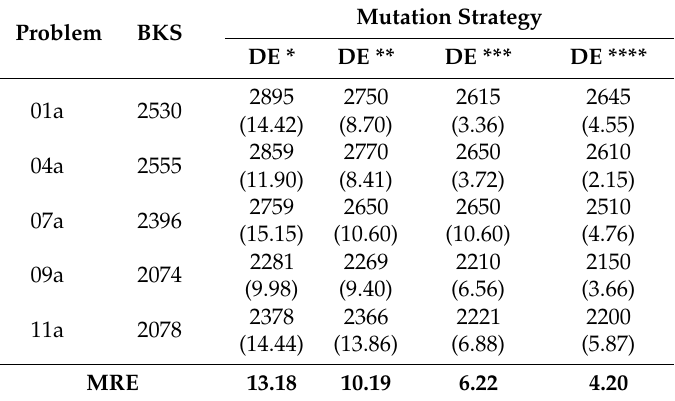
Table 16. Summary of solving the flexible job shop scheduling problem with sample problems Dauzere-Peres and Paulli.